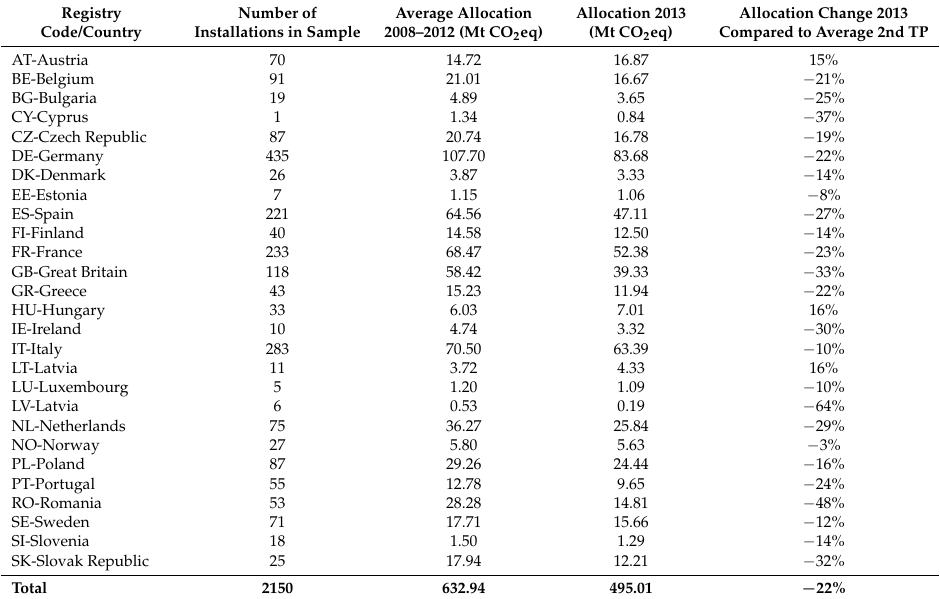
Table 2. Sample size and distribution of the average allocation change in 2013 compared to the average of the 2nd Trading Period (TP) by country (Registry